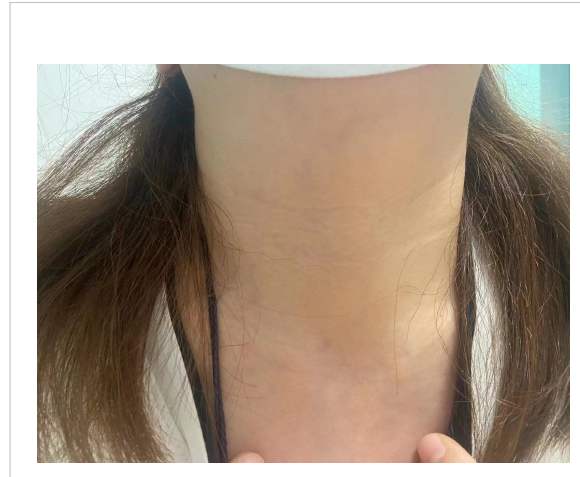
FIGURE 2 Three months after surgery, an anterior neck image of a patient in the gasless